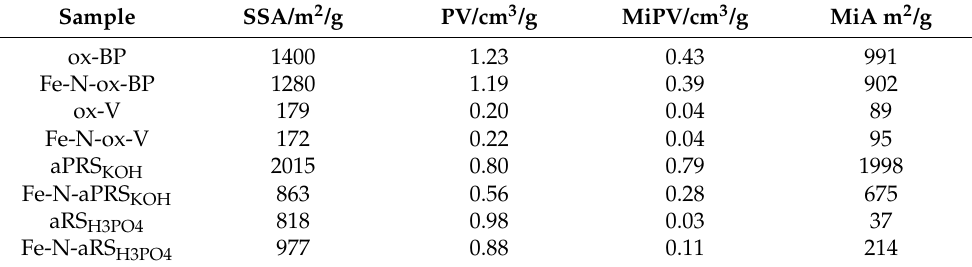
Table 1. Specific surface area (SSA), pore volume (PV), micropore volume (MiPV), and micropore area (MiA) derived from the N 2 sorption experiment data.